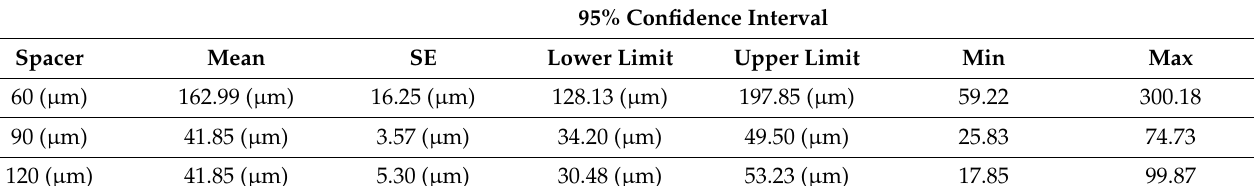
Table 1. Mean and SE for mean marginal gap (MMG) ( α = 0.05).